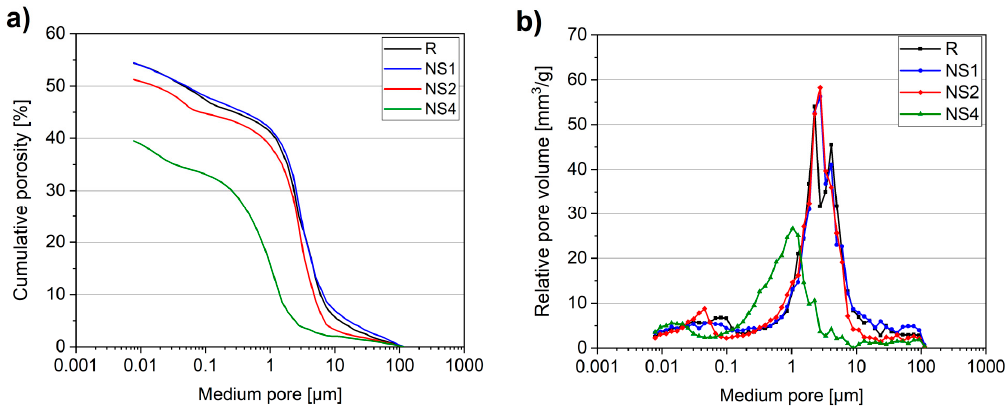
Figure 10. Cumulative porosity ( a ) and relative pore volume ( b ) of concretes obtained with the mercury intrusion porosimetry (MIP) test. Table 5. Results of the mercury intrusion porosimetry (MIP) measurements.